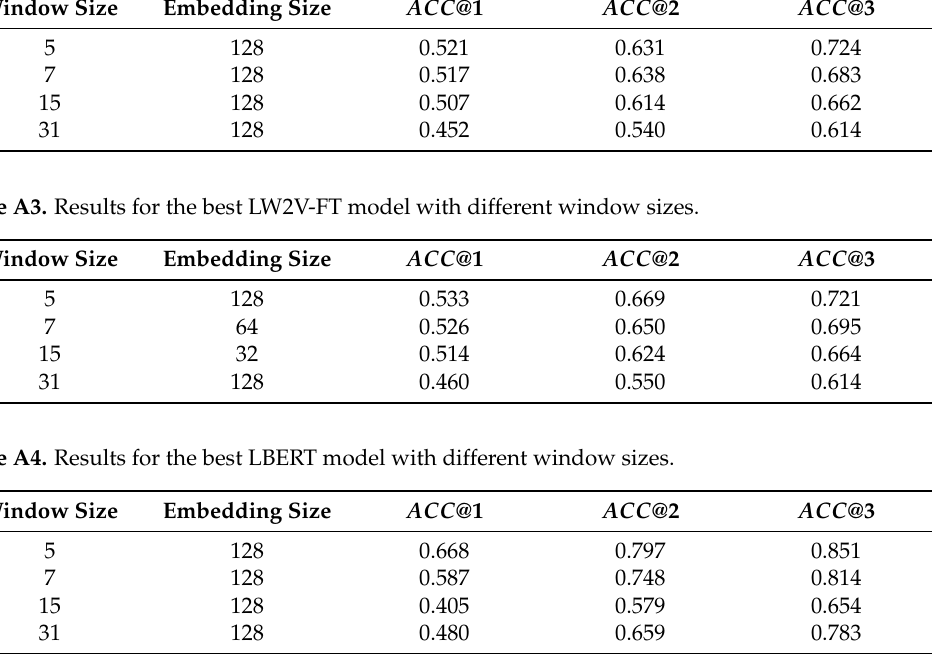
Table A2. Results for the best LW2V model with different window sizes. Window Size